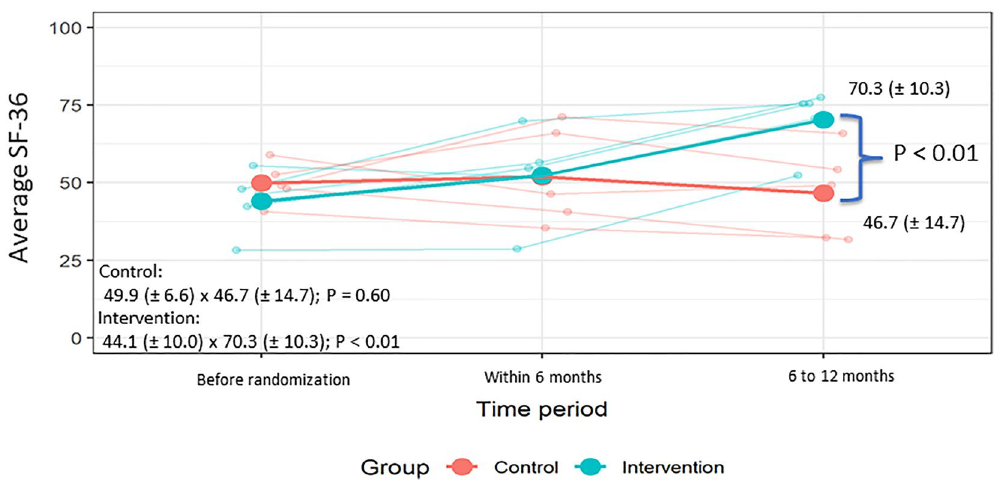
Figure 3. Comparison of average of SF-36 at baseline, 6 months and 12 months. Each light line represents one patient while the dark (dense) line represents the average of the group (each group is identified by a different colour).